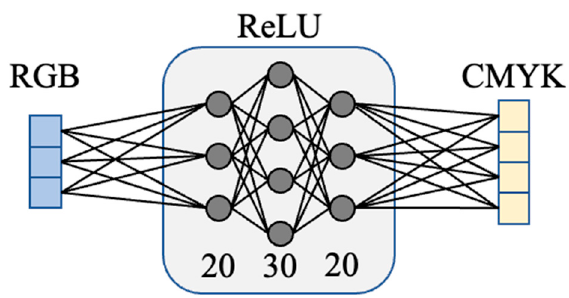
Figure 7. Illustration of our network structure.